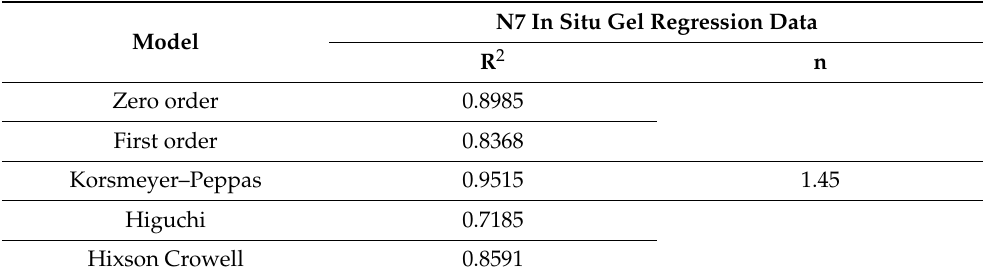
Table 5. Release kinetic models used to describe DRN release from optimal niosomal in situ gel.